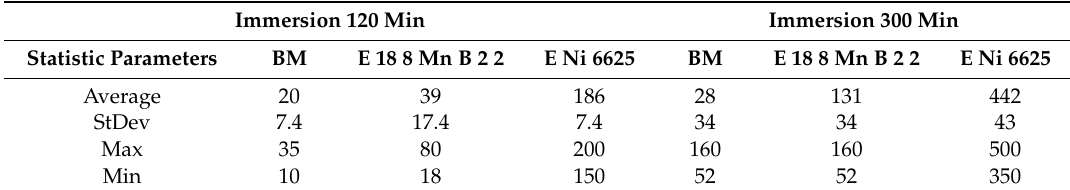
Table 13. Thickness of compact intermetallic layer ( μ m).